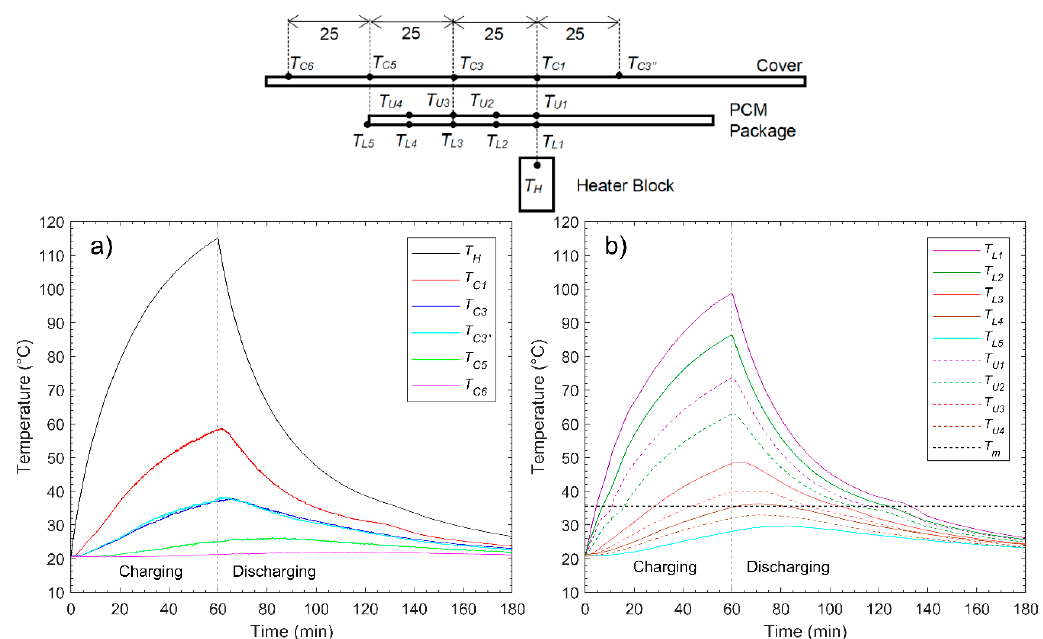
Figure 4. ( a ) Temperature profile of the heater ( T H ) and cover surface ( T C ); ( b ) Temperature profiles of the upper ( T U1 –T U4 ) and lower ( T L1 –T L5 ) surface of the PCM package A ( n -eicosane) for the experiment with a constant power input of 5 W for 60